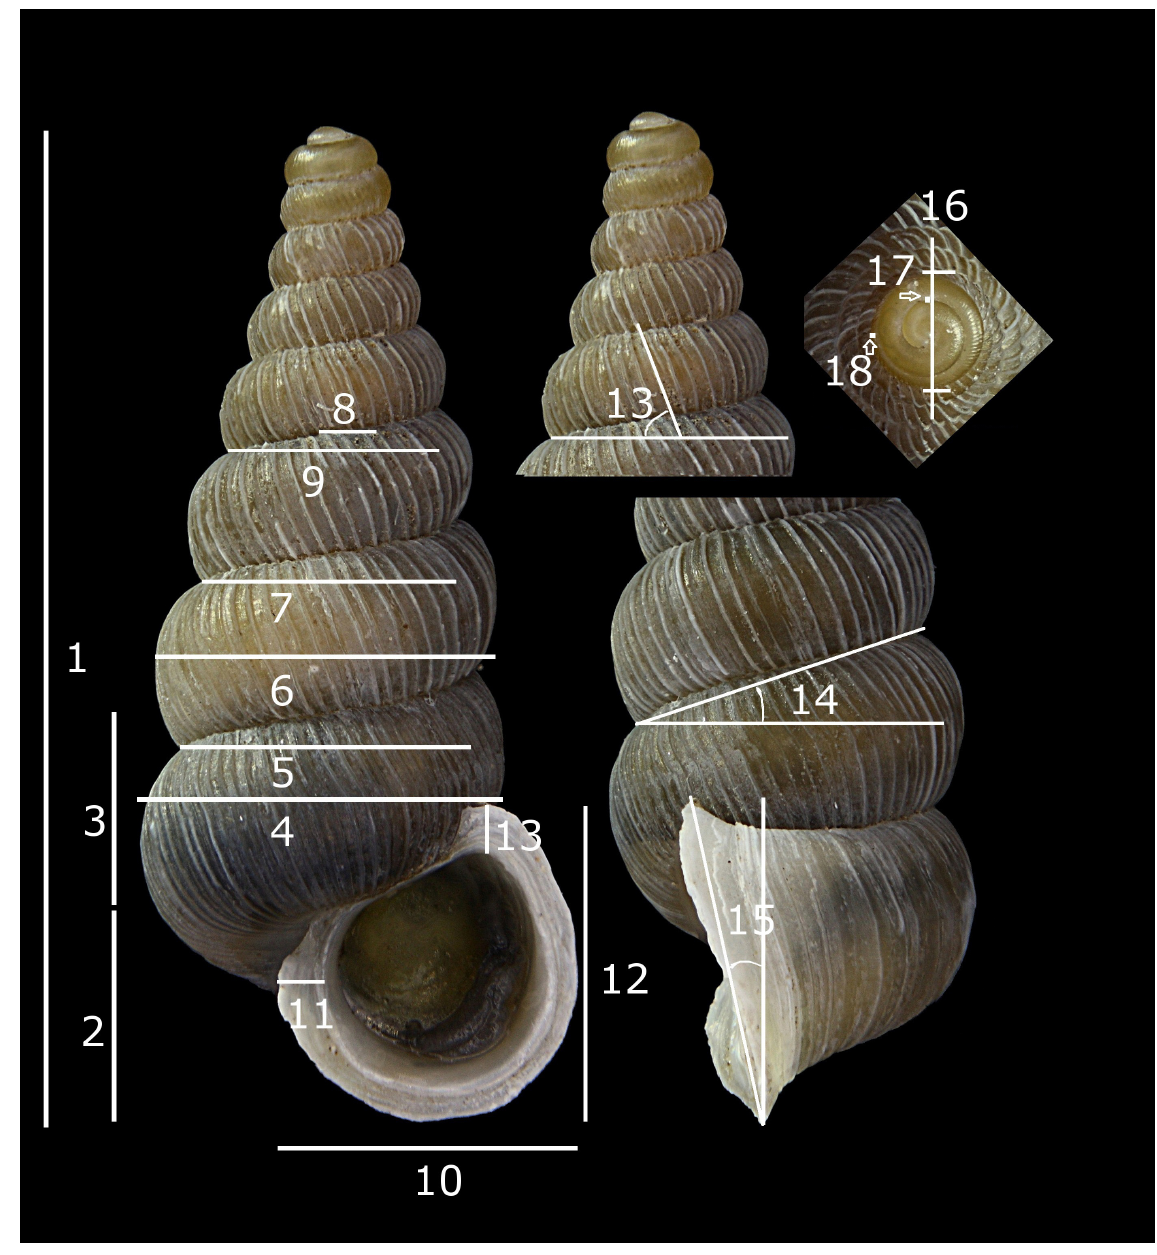
Fig. 2. Potentially diagnostic distances and angles. 1 = shell height (H). 2 = height of aperture at the columellar side. 3 = height of the first whorl. 4 = width of body whorl (Wbw). 5 = width of the suture above the body whorl. 6 = width of the penultimate whorl. 7 = width of the suture above the penultimate whorl. 8 = distance between the 5 most central ribs on the 4 th whorl up. 9 = diameter of the 4 th whorl up. 10 = aperture width (Wa). 11 = width of the lip at the columellar side. 12 = aperture height (Ha). 13 = rib inclination. 14 = suture inclination. 15 = aperture inclination. 16 = protoconch diameter in upper view (Dp). 17 = end of the smooth part of the protoconch. 18 = end of the